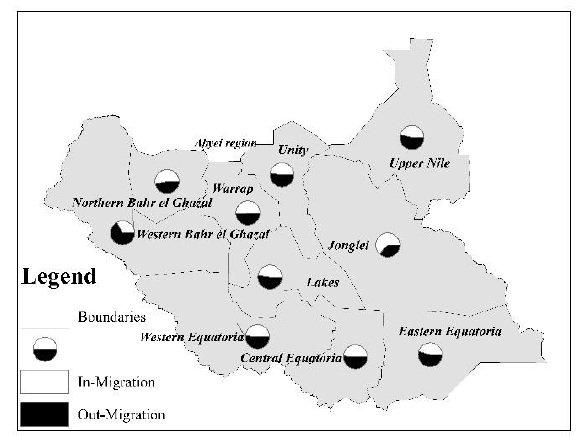
Figure 2. WorldPop Internal Migration Estimates, 2005-2010